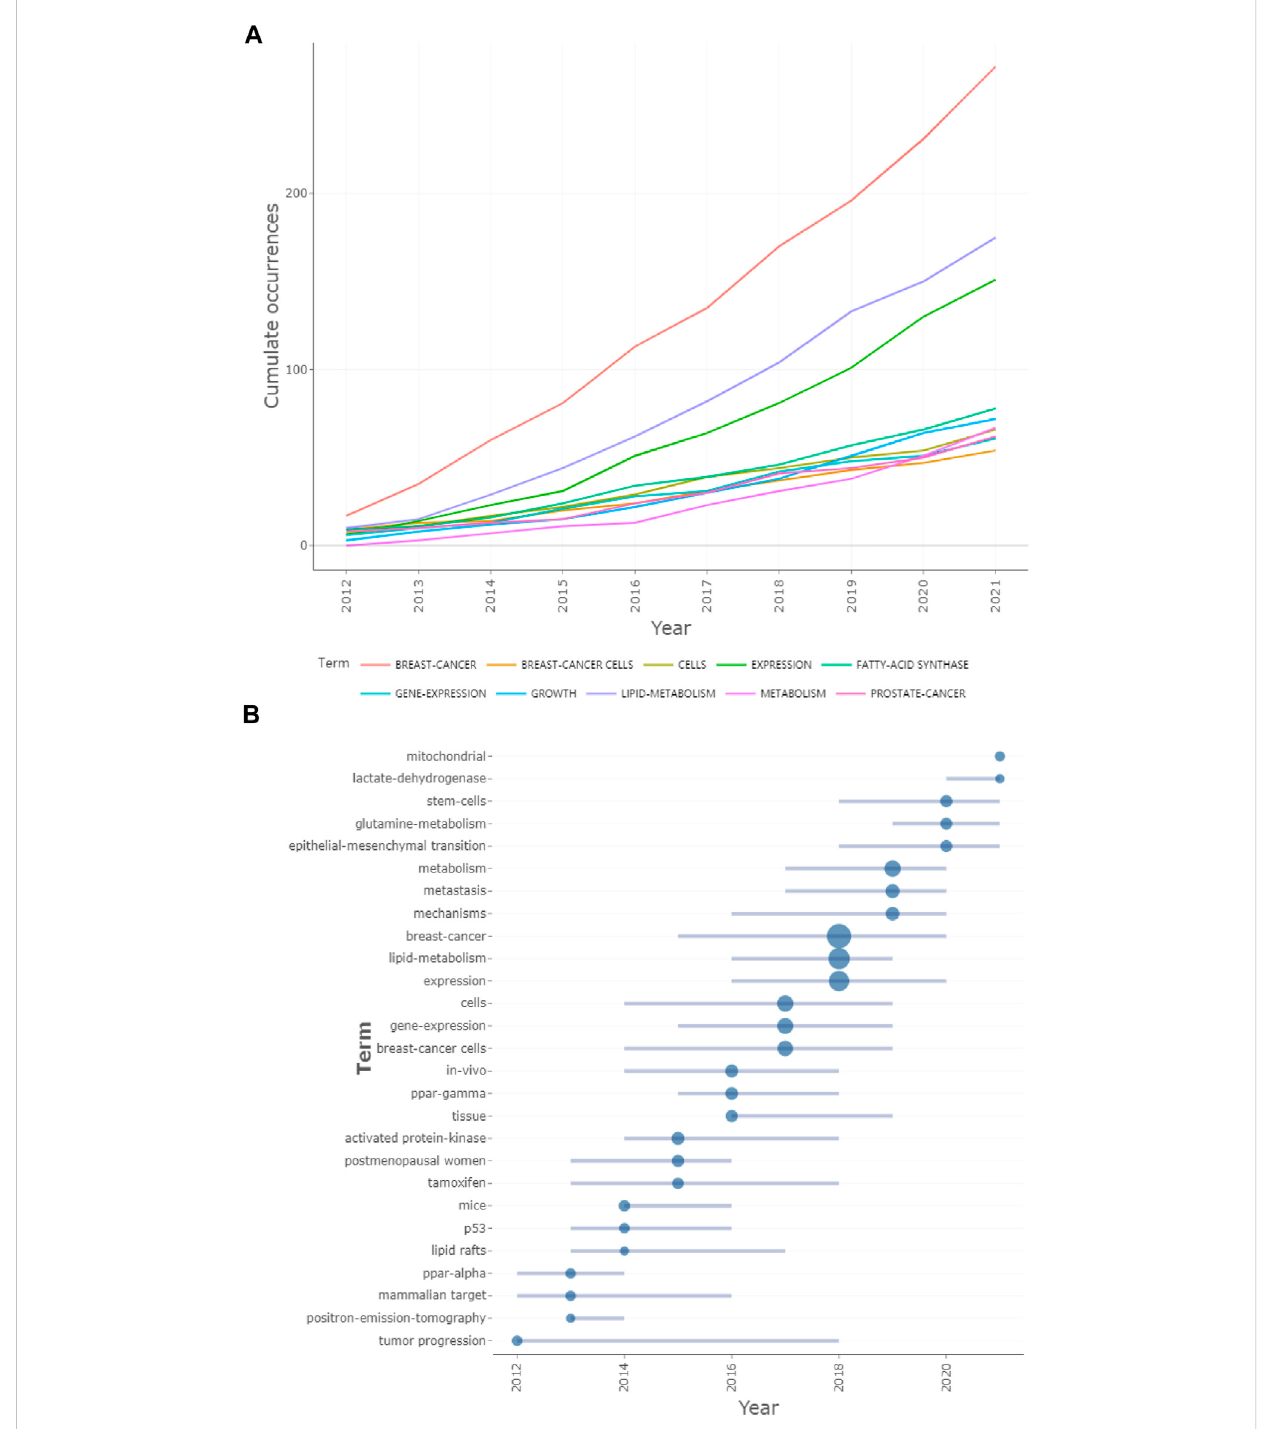
The trend of the top 10 keywords in frequency and trend topic. (A) The trend of the top ten most frequently used keywords. (B) Trend topic of lipid metabolism in breast